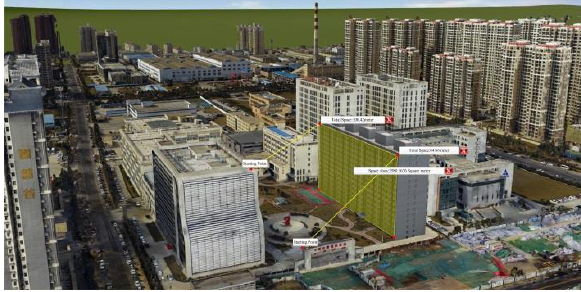
Figure 11. Space area and distance measurement